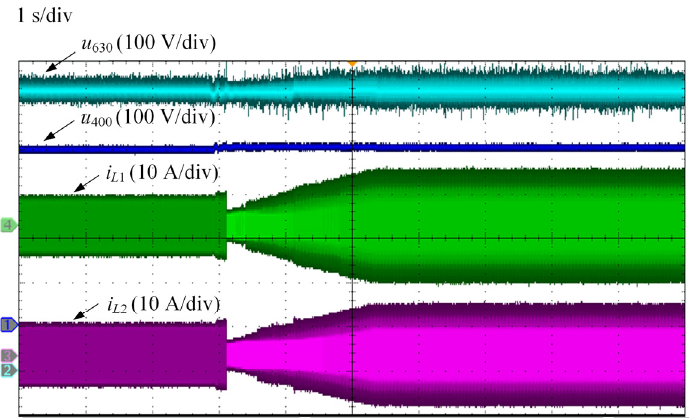
Figure 18. Waveforms of AC load increases from 0 to 7 kW in on-line mode with the original control method.